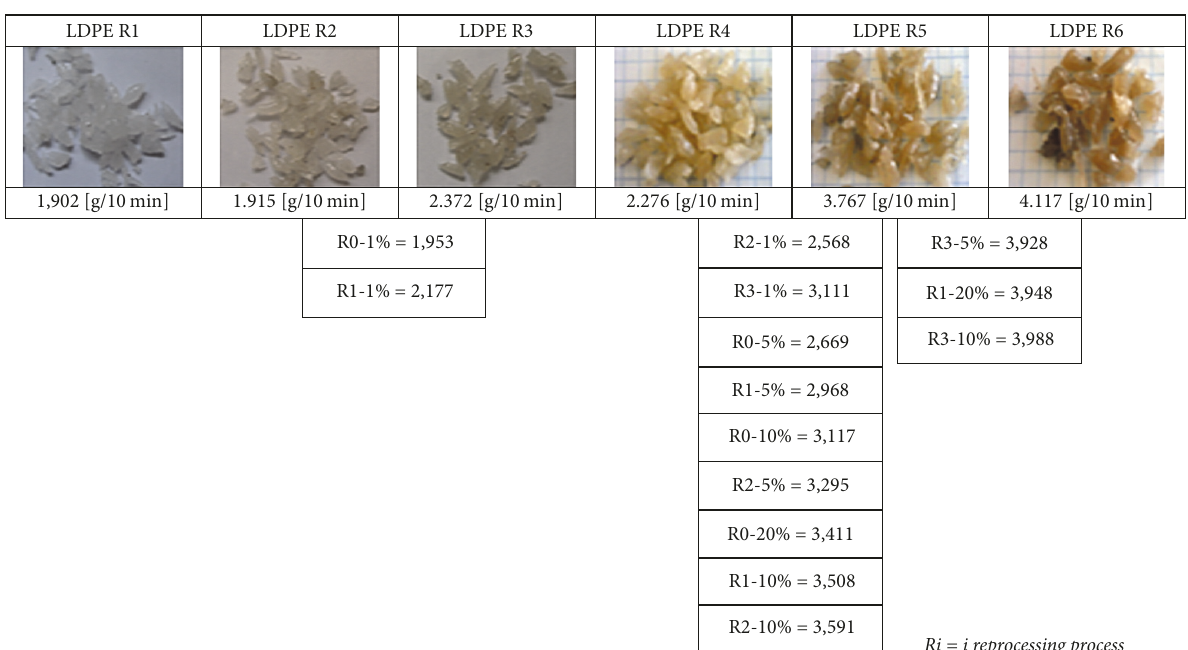
Figure 8: Comparison of the MFI values between the aged oxo-degradable/LDPE blends and the neat LDPE considering six reprocessing cycles.